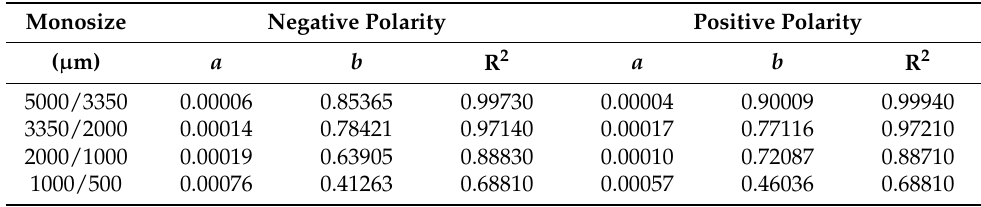
Table 4. Model parameter values calculated.